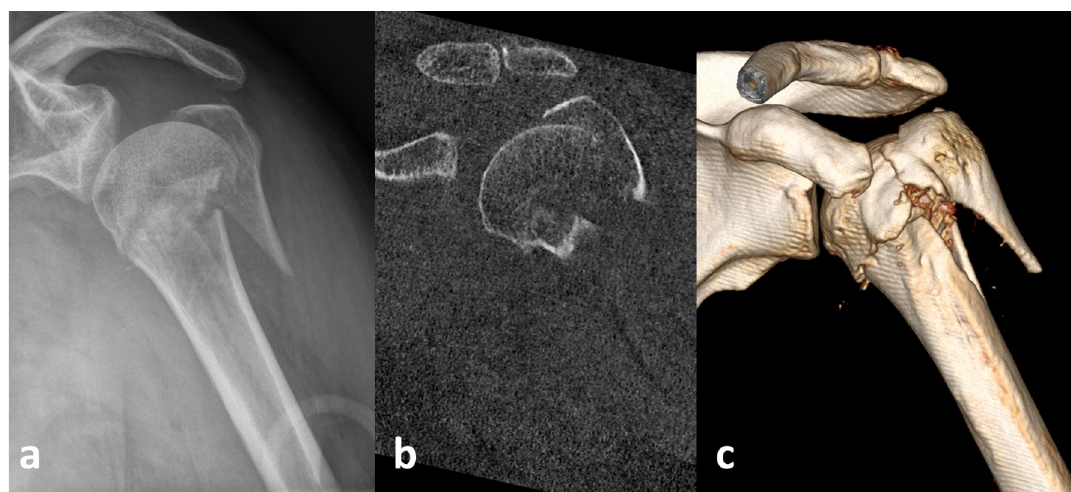
Fig 2. Split type 2 of GT fragment according to the morphological Mutch classification in a multi-part fracture of a 62-year-old patient. Plain radiograph (a), 2-D CT (b), and 3-D CT (c).